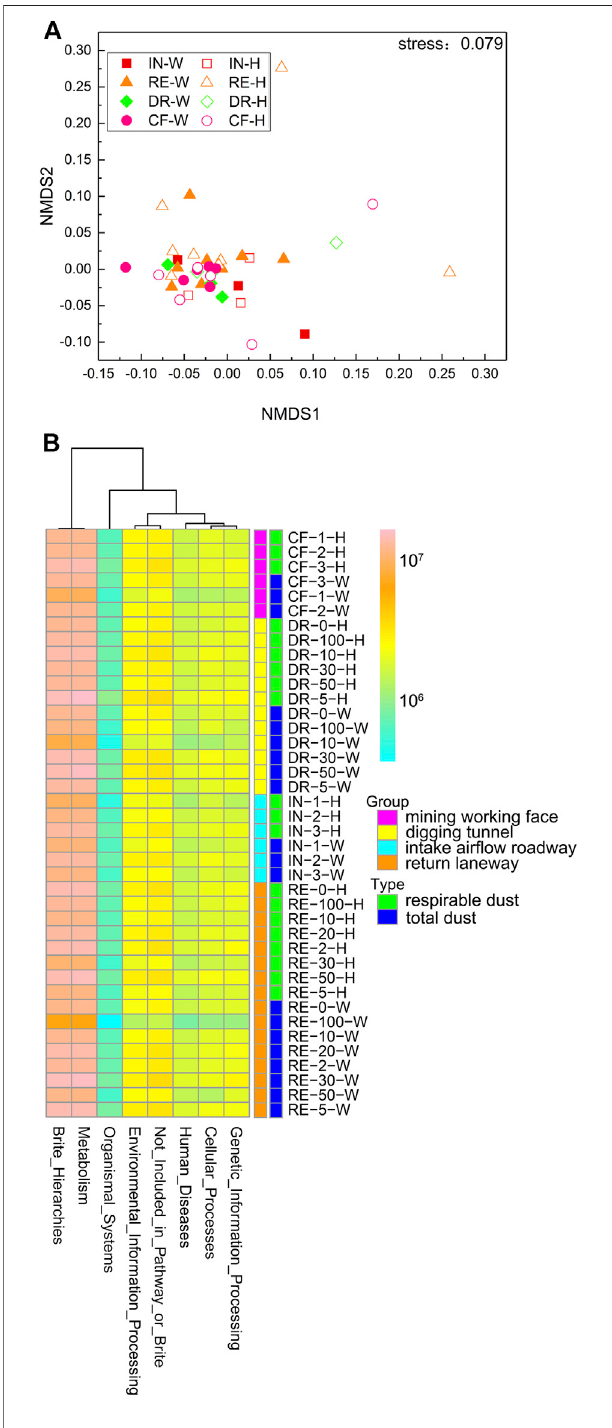
FIGURE2| NMDS ofthepredictive functioncompositionbyBray-Curtis dissimilaritiesindustsamples (A) ;Heat mapofthepredictive functions atlevel 1 in dust samples (B) . IN-W, total dust in intake air fl ow roadway; IN-H, respirable dust in intake air fl ow roadway; RE-W, total dust in return laneway; RE-H, respirable dust in return laneway; CF-W, total dust in mining working face; CF-H, respirable dust in mining working face; DR-W, total dust in digging tunnel; DR-H, respirable dust in digging tunnel. Different lowercase letters were signi fi cantly different from each other ( p < 0.05,